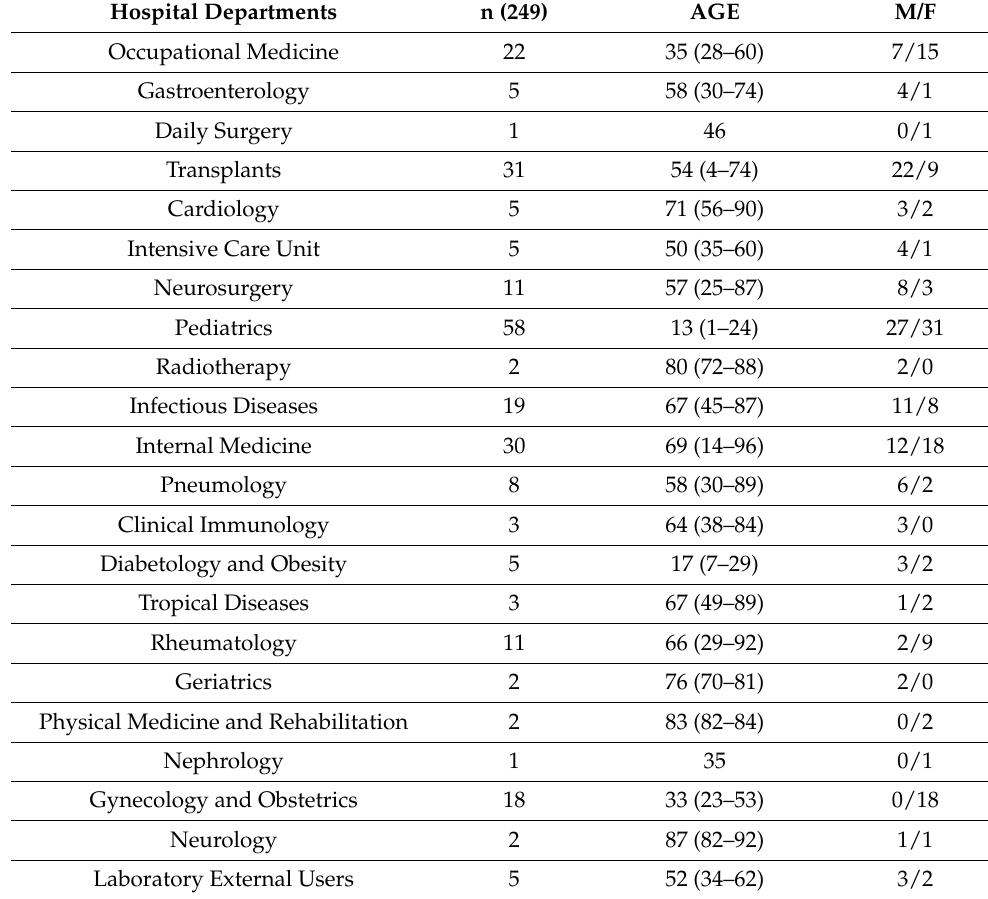
Table 1. Characteristics of the 249 included individuals involved in the study. Departments,